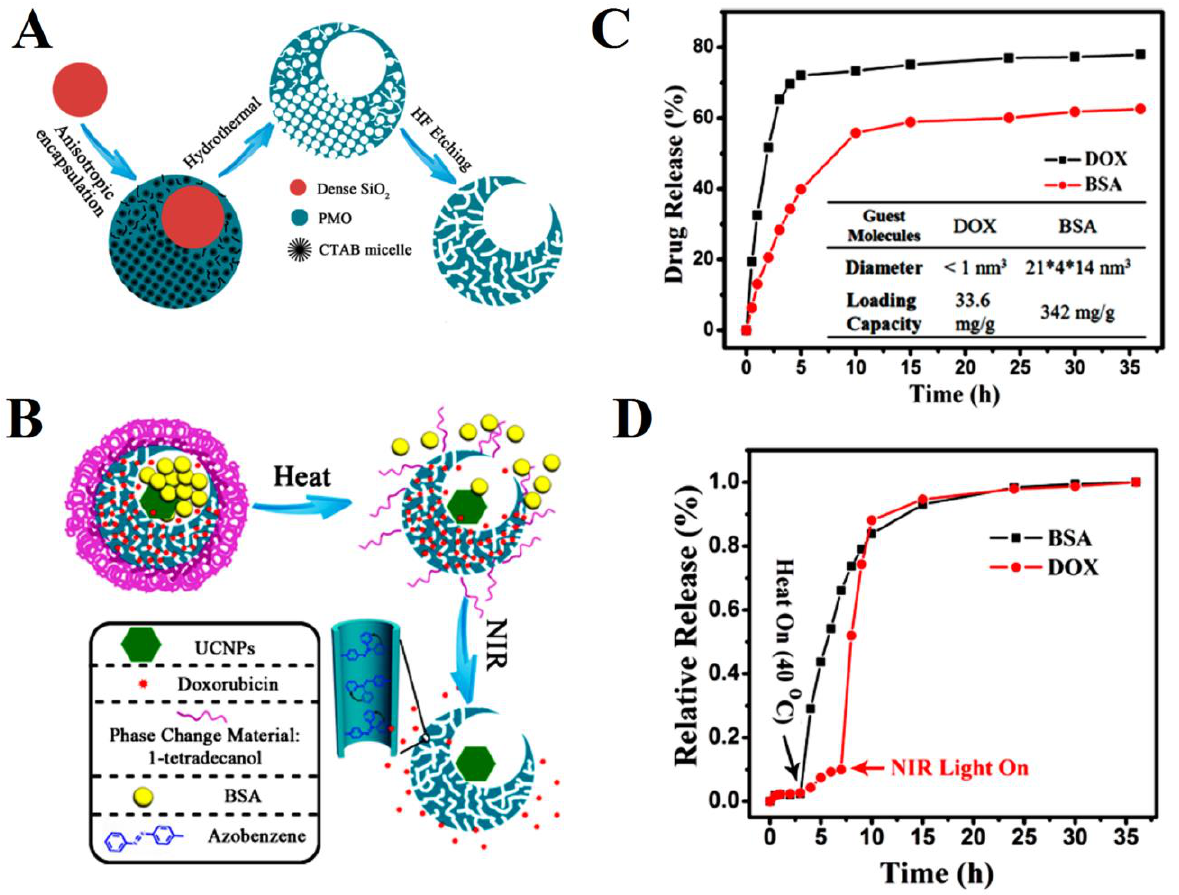
Figure 9. ( A ) Single-hole anisotropic mesoporous silica nanoparticle synthesis schematics. ( B ) Dual- loaded nanoparticle release mechanism through induction of heat and NIR irradiation. ( C )